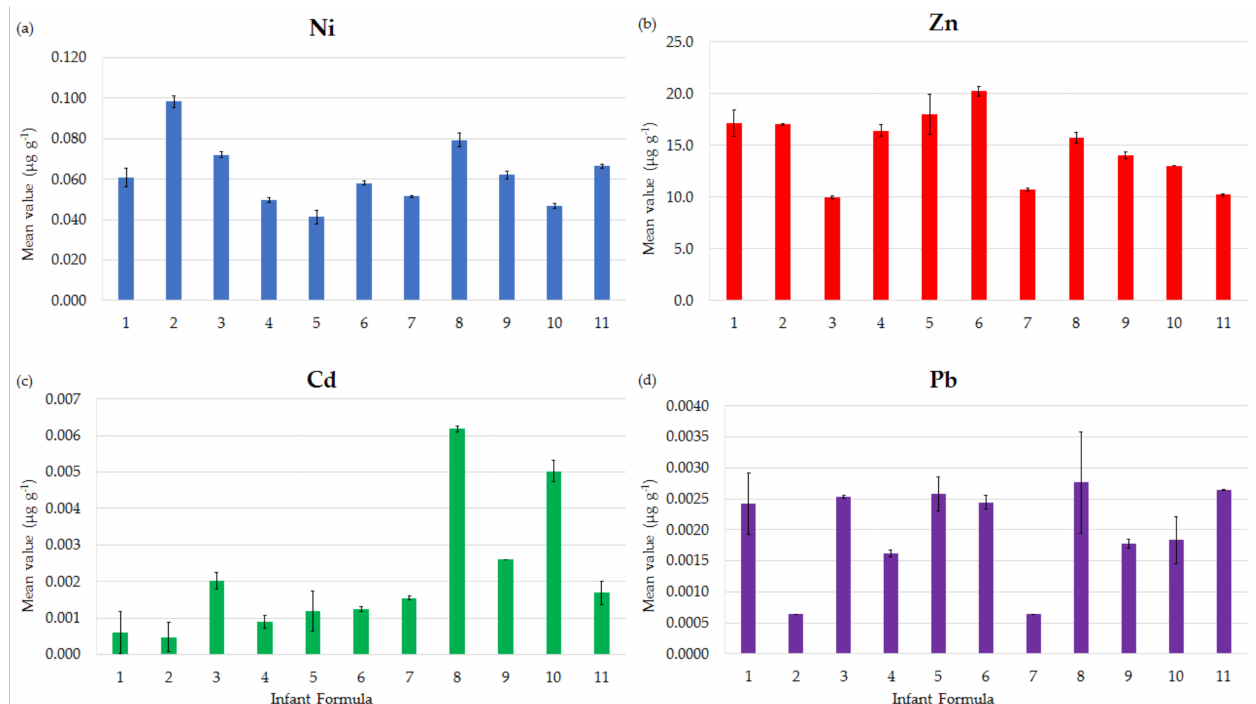
Figure 1. Mean values of the concentration, expressed in µ g g − 1 for each formula, of ( a ) Ni, ( b ) Zi, ( c ) Cd and ( d ) Pb. The black line on each bar represents the standard